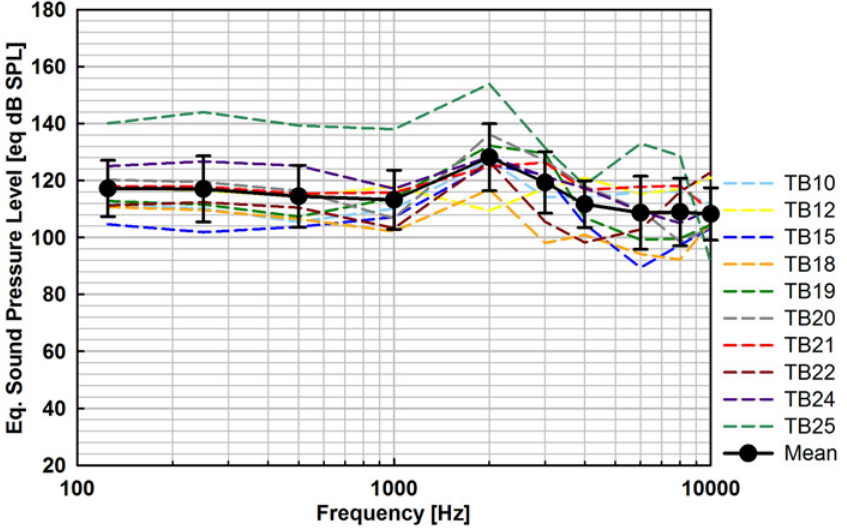
increased spread at higher frequencies (Fig. 8). Except in two experiments (TB19, TB20) all ob- tained SPL were > 90 eq. dB SPL in the entire frequency range. At frequencies (cid:1) 1 kHz the mean eq. SPL was between 112.8 and 124.5 eq. dB SPL and at frequencies > 1 kHz between 108.6 and 131.6 eq. dB SPL with standard deviations up to 21.9 dB. The average output at